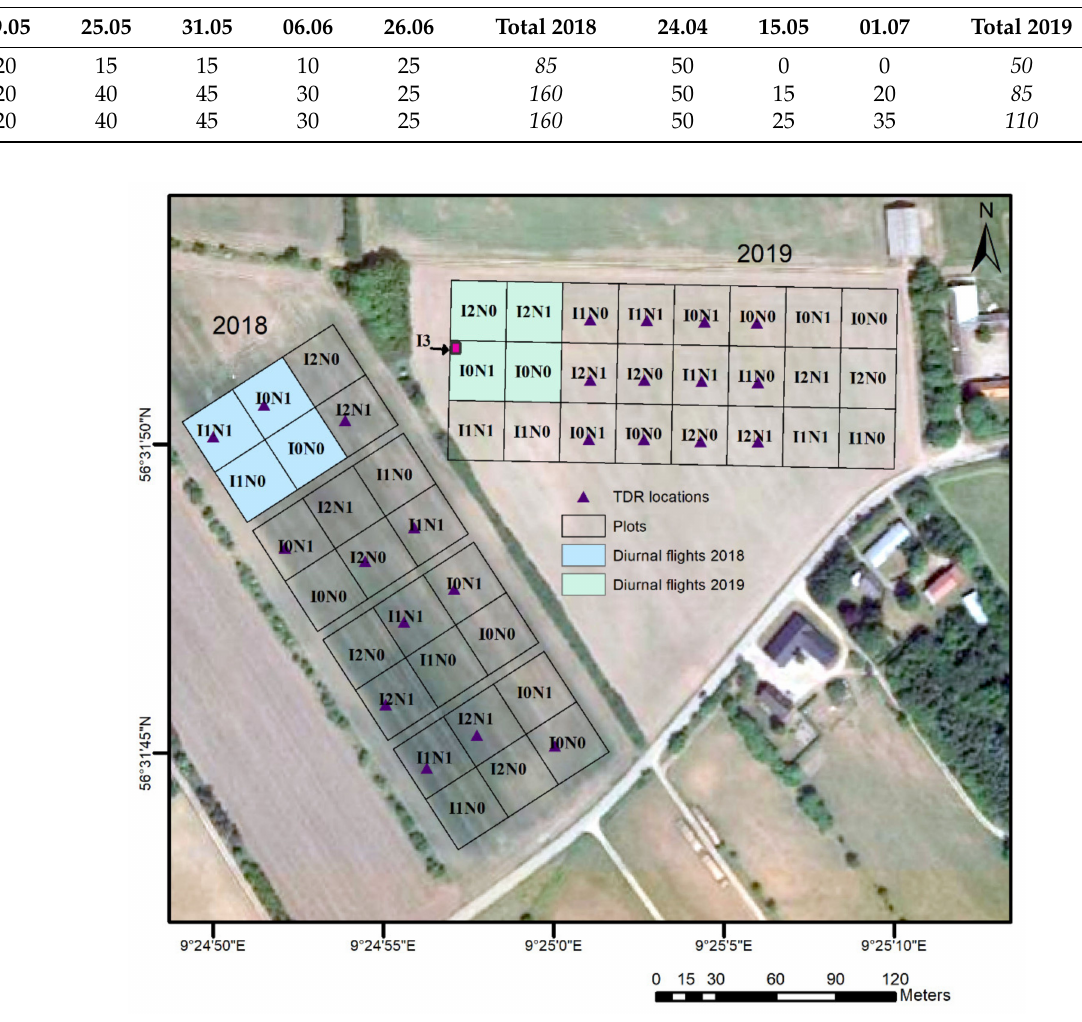
Figure A1. Treatment plots of winter wheat experiments in 2018 and 2019 in Denmark. Treatments of irrigation are minimum (I0), optimum (I1) and full (I2) and nitrogen fertilization of basic (N0) and full (N1). Blue are the 4 selected plots for the diurnal flights on 6 June 2018, and green are the 4 selected plots for the diurnal flights on 28 June 2019, where I3 is a small (3 × 2 m) plot that was separately irrigated before the day of the